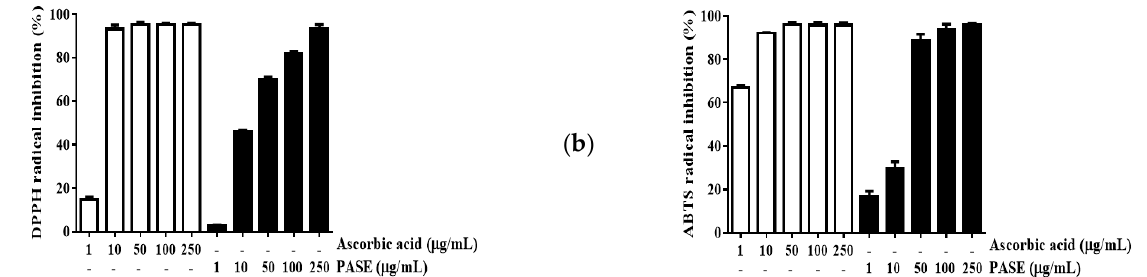
Figure 2. DPPH and ABTS radical scavenging activity of PASE: DPPH radical ( a ) and ABTS+ cation ( b ) scavenging activity of PASE. Ascorbic acid was used as a positive control. Data are presented as means ± SDs of three replicates.